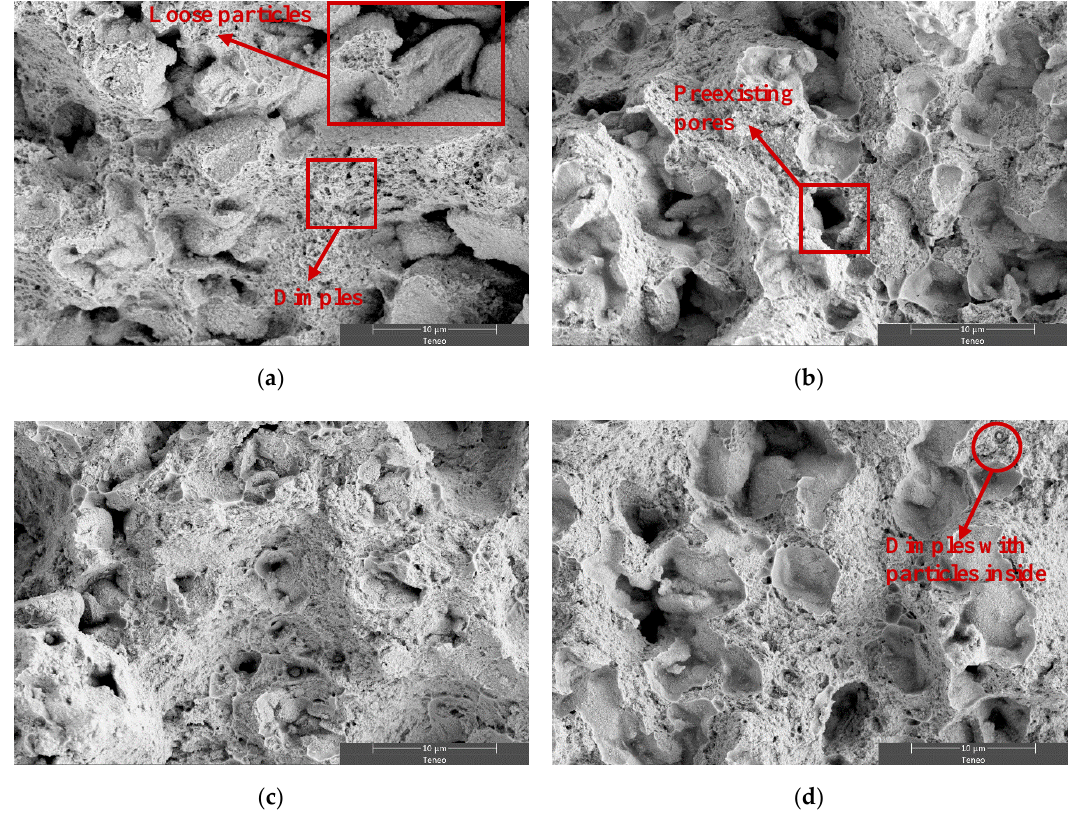
Figure 6. SE-SEM microfractographs of ( a ) V, ( b ) F5, ( c ) F10, and ( d ) C. A tensile test was carried out at room temperature after a heat treatment at 400 °C for 100 h.